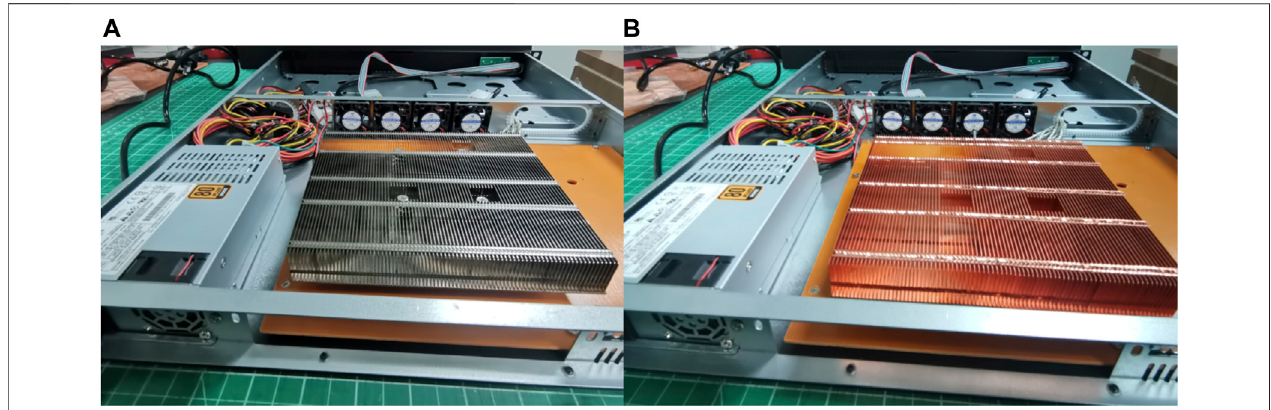
FIGURE 6 | Heat sink of (A) commercial VC-based and (B) our PHP-based radiator for 1U server heat dissipation.